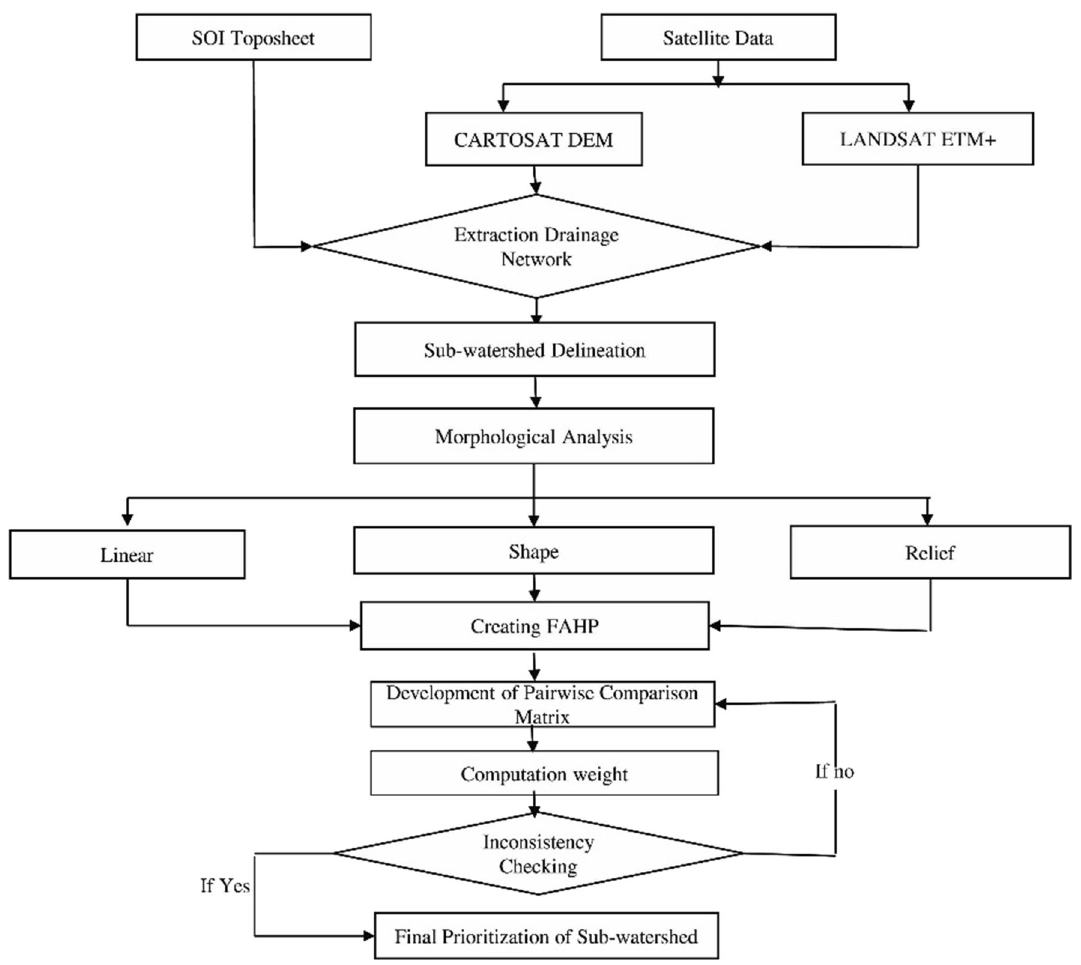
Fig. 2 Flowchart of methodology for sub-watersheds